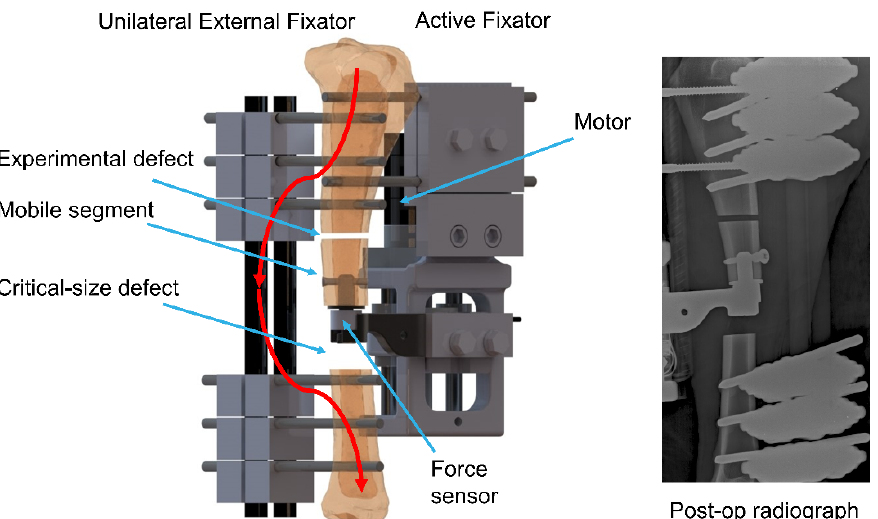
Figure 1. Configuration of the experimental setup. The distal and proximal parts of the tibia are fixed with an external fixator which transfers physiological loading (red line). The mobile fragment is connected to the proximal part via an active fixator that moves it to stimulate and monitor healing in the experimental